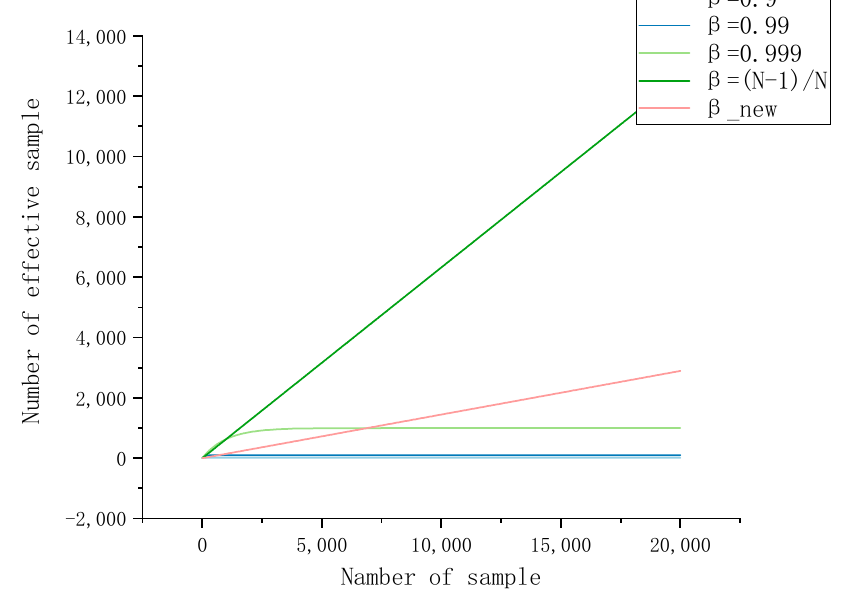
Figure 7. Comparison between the original effective sample algorithm and the algorithm in this paper ( β new